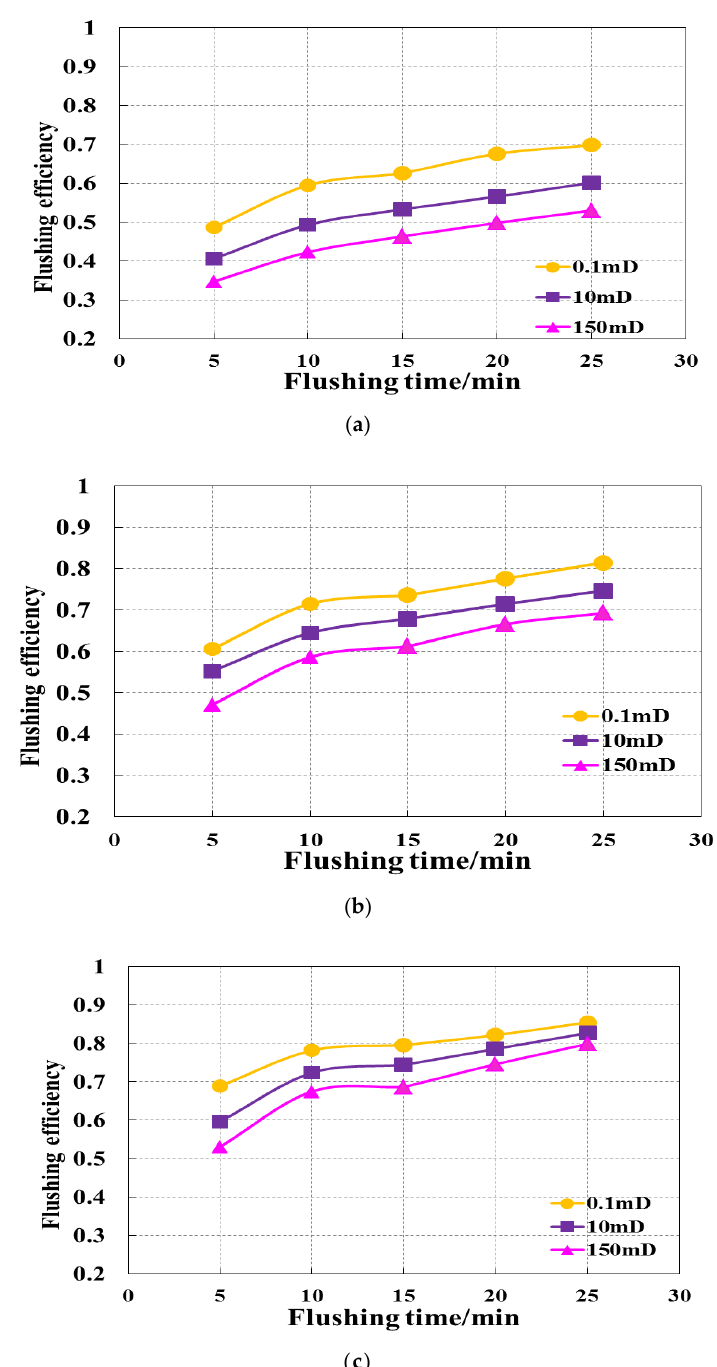
Figure 8. Variation of flushing time and flushing efficiency of different cores under the condition of 10% flushing concentration. ( a ) is flushing displacement 10 L / min, ( b ) is flushing displacement 25 L / min, ( c ) isflushingdisplacement35 L/min.